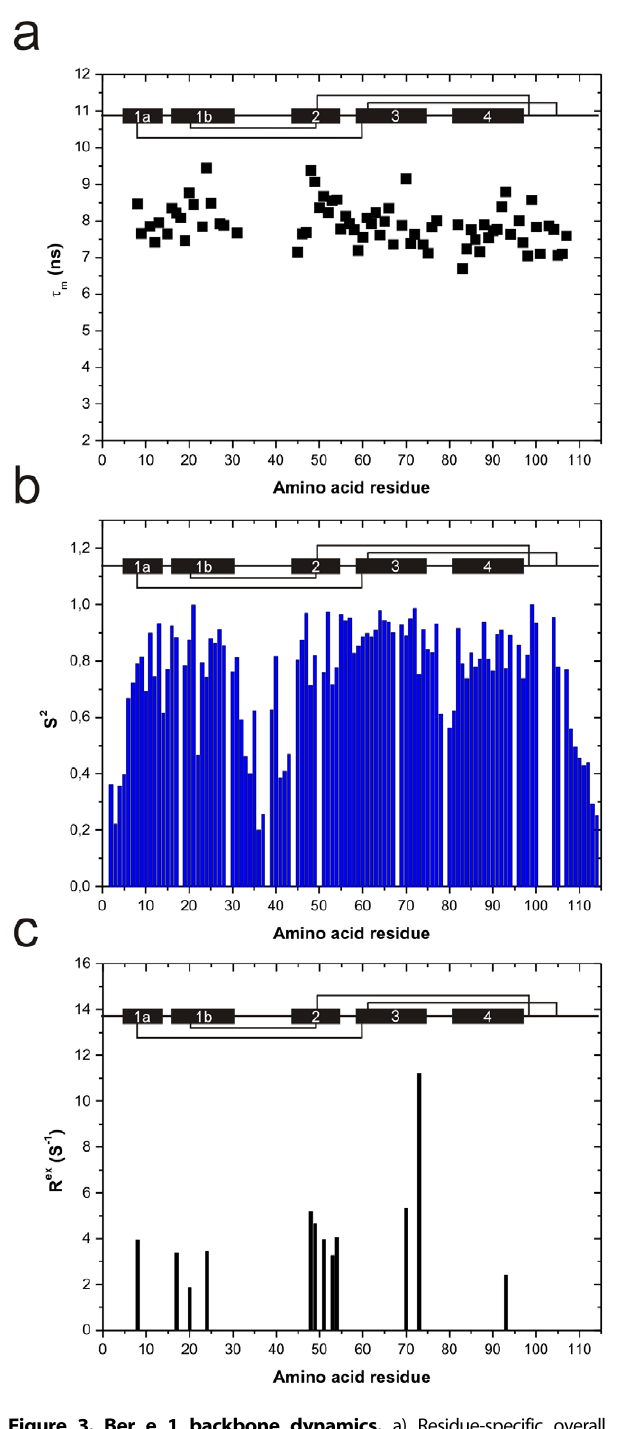
Figure 3. Ber e 1 backbone dynamics. a) Residue-specific overall tumbling time ( t m ) values for 77 of 114 residues. The relatively uniform t m values indicate isotropic tumbling of Ber e 1. b) Order parameter, S 2 , of the N-H bond vector on a per residue basis. An S 2 value of 1equals a completely rigid N-H vector, whereas an S 2 value of 0 implies complete rotational freedom of the N-H vector. Some flexibility is observed in the hypervariable loop, and the N- and C-terminal, as well as the non-native loop show high flexibility. c) R ex parameter, showing the residues where m s-ms dynamics could be identified. Slow dynamics is largely located to the interface of helix 1b and 2, as well as at the end of helix 3, leading intothe hypervariable loop. The secondary structure elements, as well as the cysteine linkage are indicated in the top of each